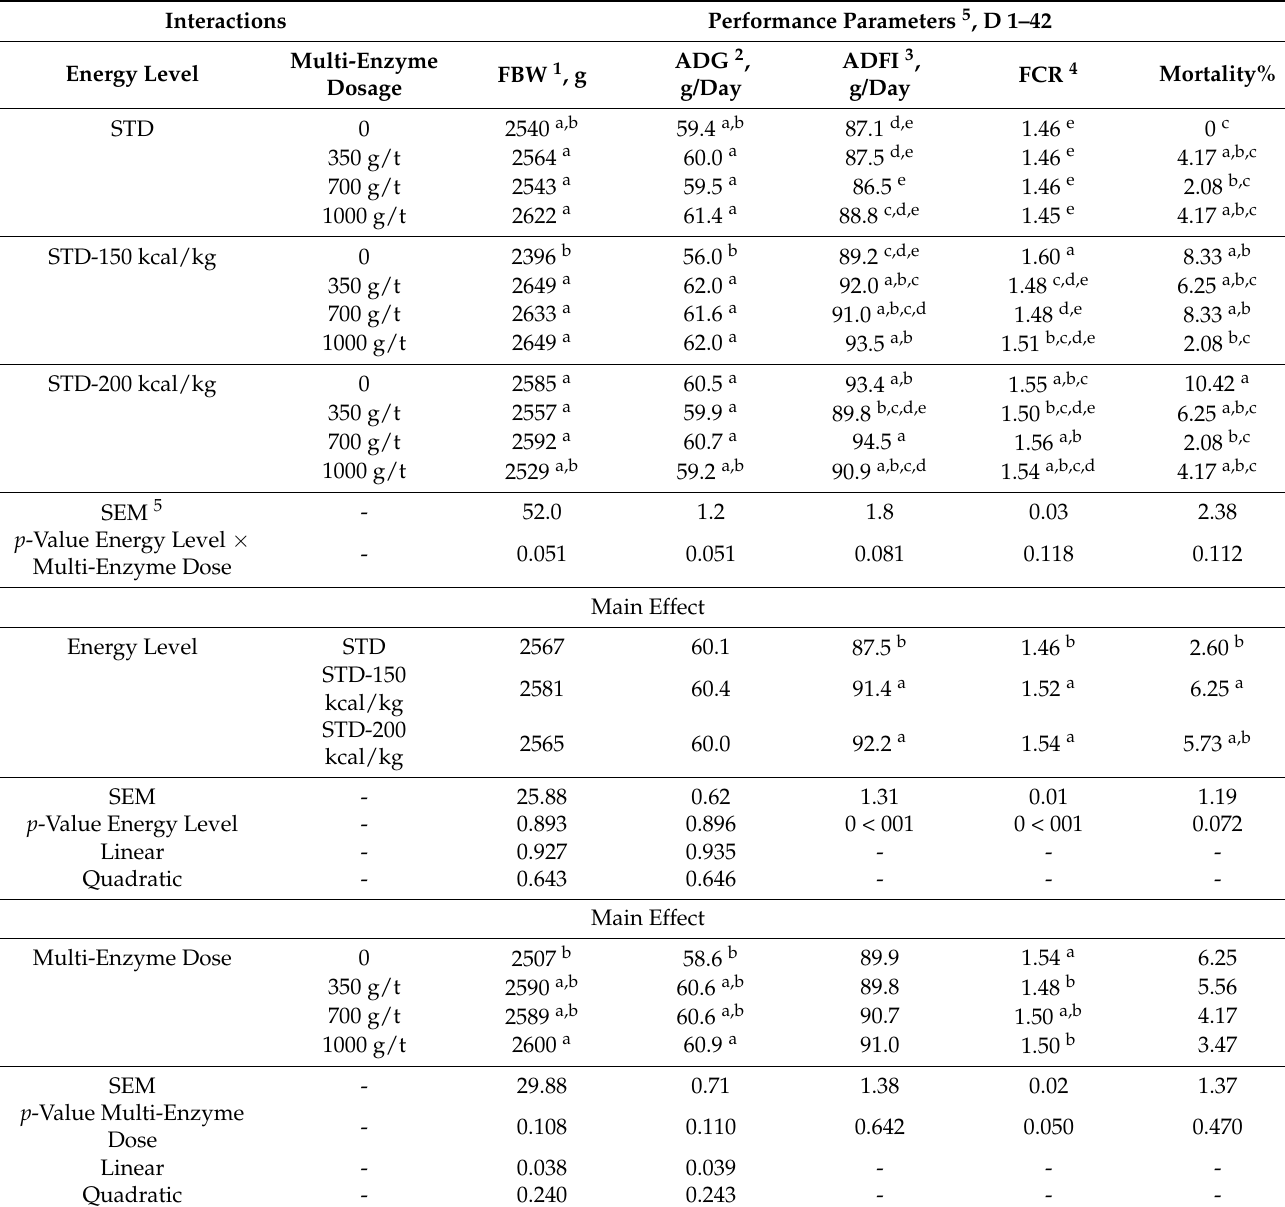
Table 3. Effects of multi-enzyme super-dosing in reduced energy diets on broiler growth performance parameters.